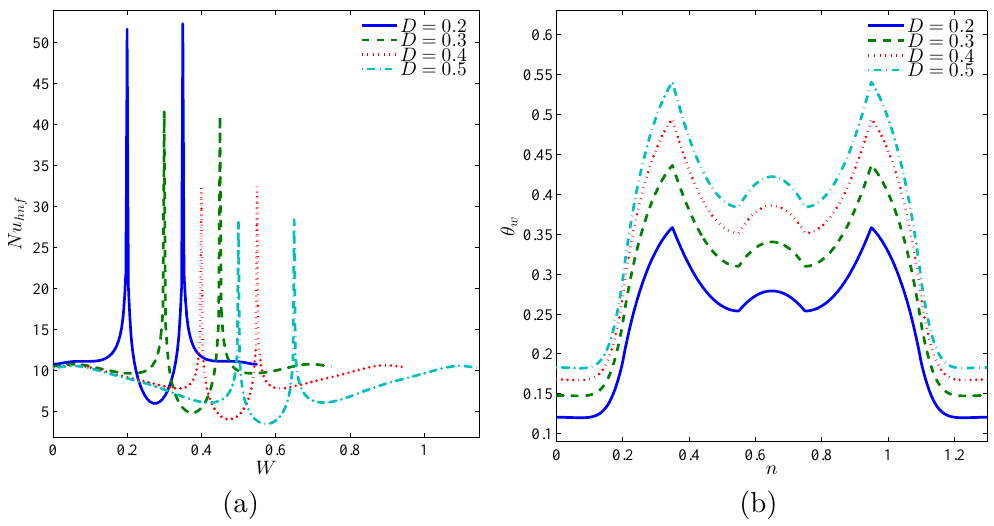
Figure 14. Evaluation of ( a ) local Nusselt number interfaces with W and ( b ) local dimensionless temperature on the solid blocks with different D for hybrid nanofluids; Ra = 10 5 and φ = 0.02.